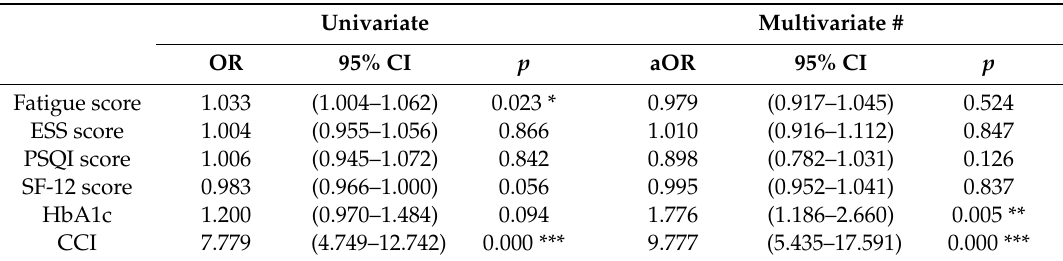
Table 3. Logistic regression analysis of nephropathy risk factors with fatigue, ESS, PSQI, SF-12, HbA1c, and CCI included as continuous